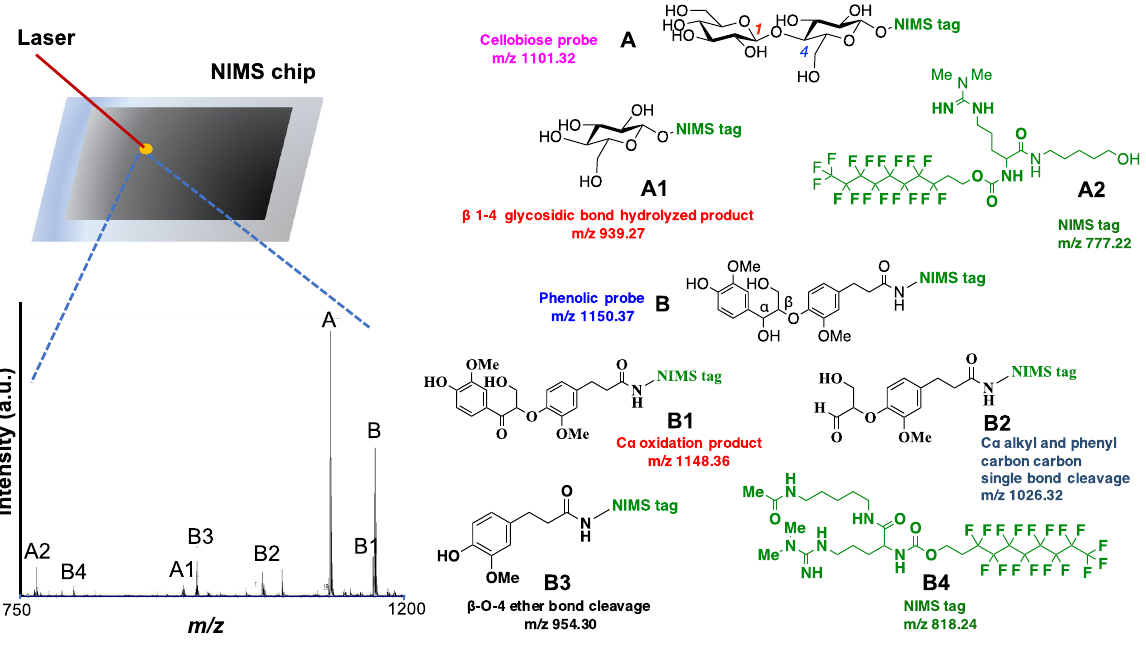
Figure 1. Concept of a NIMS multiplexed glycoside hydrolase and lignin modifying enzyme